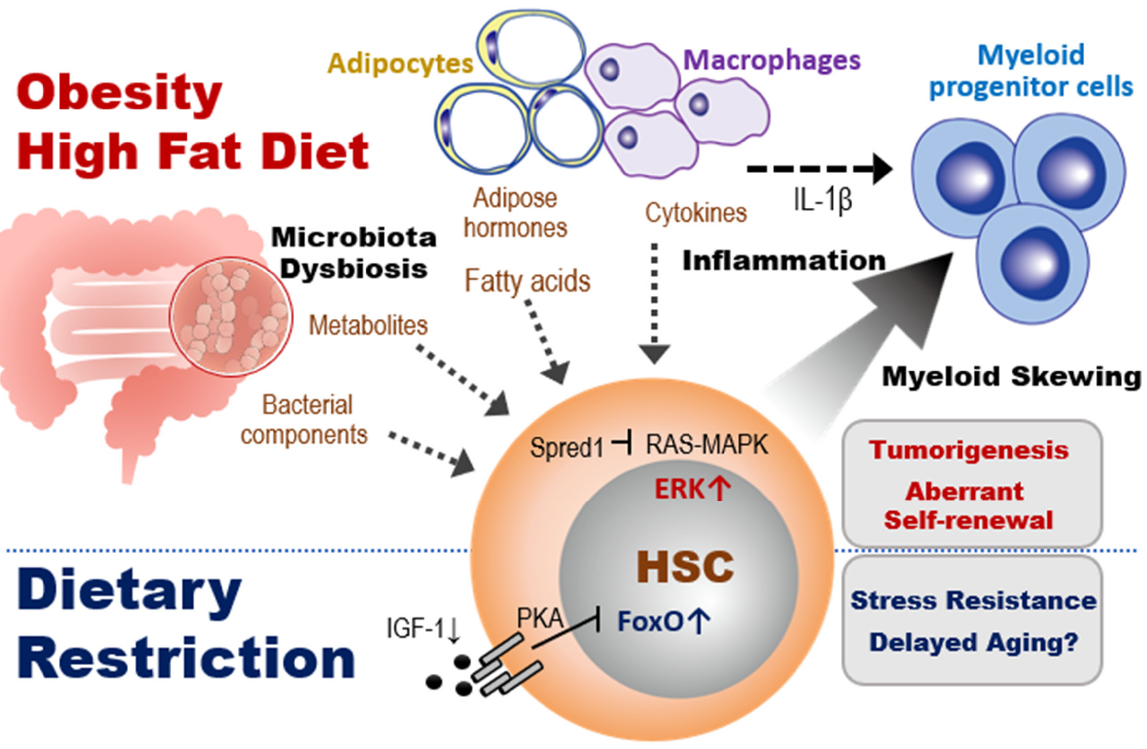
Figure 3. Impacts of dietary interventions on HSCs and myeloid progenitors. Top section: Obesity or HFD alters the spectrum of bacterial and adipocyte products and macrophage-produced cytokines that act on HSCs in the BM. In the presence of inflammation, these changes promote macrophage secretion of cytokines that cause HSCs to undergo abnormal self-renewal and a skewing to myeloid progenitor differentiation. In tumor-prone mice such as Spred1-deficient animals, in which RAS- MAPK-mediated tumor suppression is lost, HFD triggers aberrant myelopoiesis leading to the development of myeloproliferative neoplasm-like diseases. Bottom section. In contrast to obesity, a DR such as fasting reduces IGF-1 and PKA signaling, which activates FoxO1. This FoxO1 activation promotes the quiescence and stress resistance of HSCs and thereby prolongs host